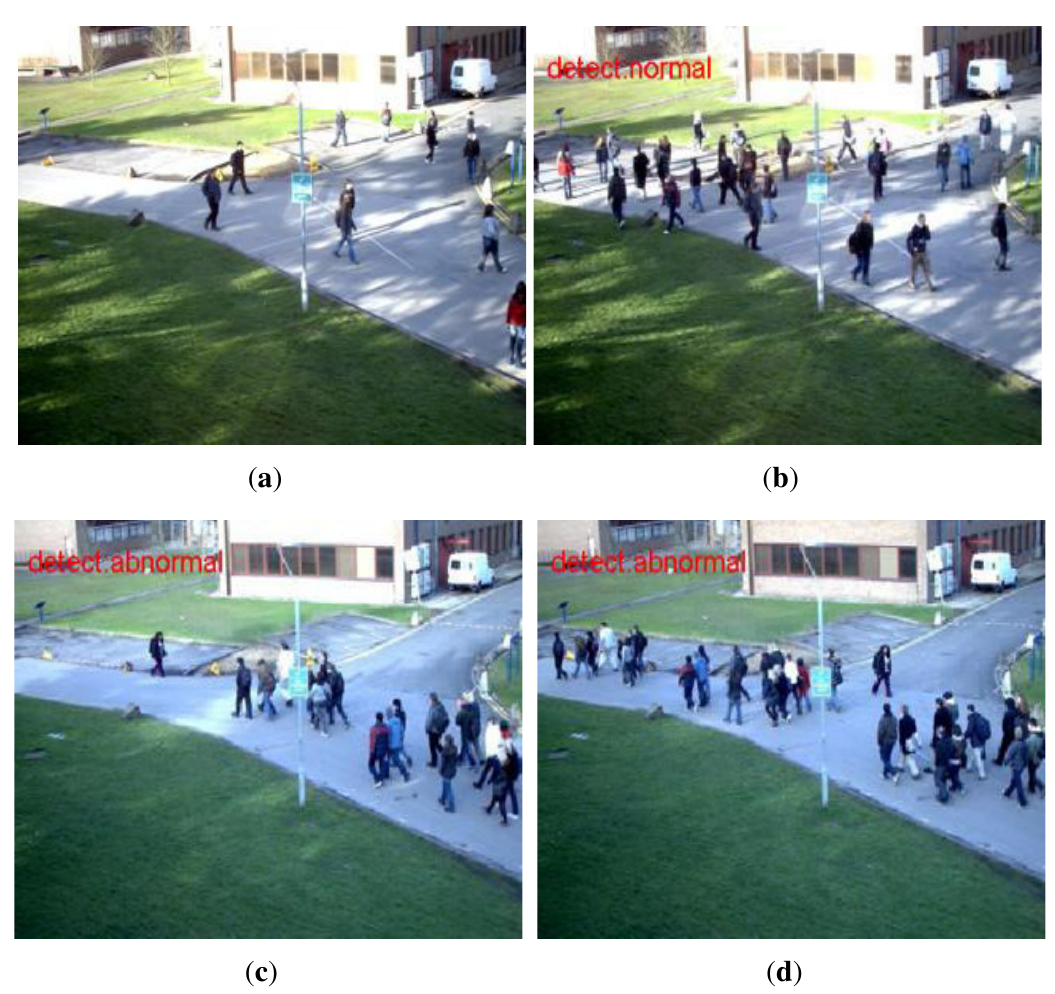
Figure 7. Detection results of the PETS scene: ( a ) training frames; people are walking in all directions; 130 frames are used for training; ( b ) a normal frame; ( c , d ) abnormal frames; people are walking in the same direction. Two hundred and nineteen frames are used for normal and abnormal testing,